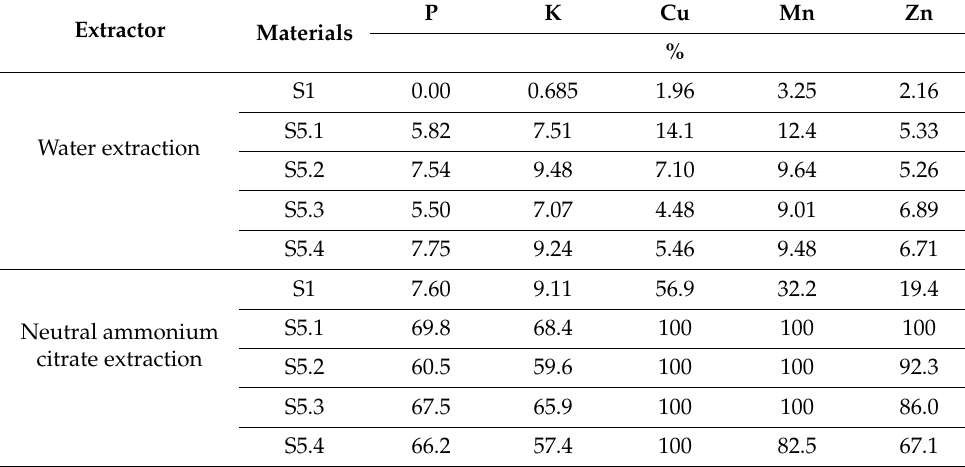
Table 8. Evaluation of leachability of elements in the coating—water and neutral ammonium citrate extraction (S1—Uncoated seeds, S5.1—Seed coating containing a solution of 2% alginate with amino